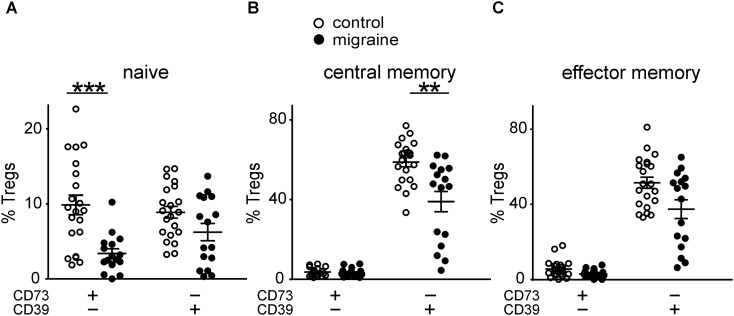
Co-expression of CD39 and CD73 by Treg subsets gated based on the CD45R0 and CD62L expression in healthy controls (white, n = 21) and patients with migraine (black, n = 16). Percentages of CD73+CD39- and CD73-CD39+ cells within “naïve” (CD45R0-CD62L+) (A), central memory (CD45R0+CD62L+) (B), effector memory (CD45R0+CD62L-) (C) Tregs. Horizontal lines indicate mean ± SEM. The differences between the groups are shown according to non-parametric Mann-Whitney test (∗∗p < 0.01, ∗∗∗p < 0.001).